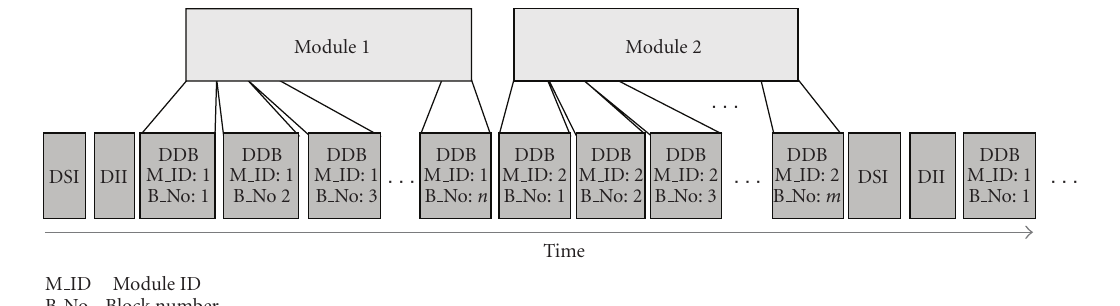
Figure 10: A typical sequence of DSM-CC download messages.